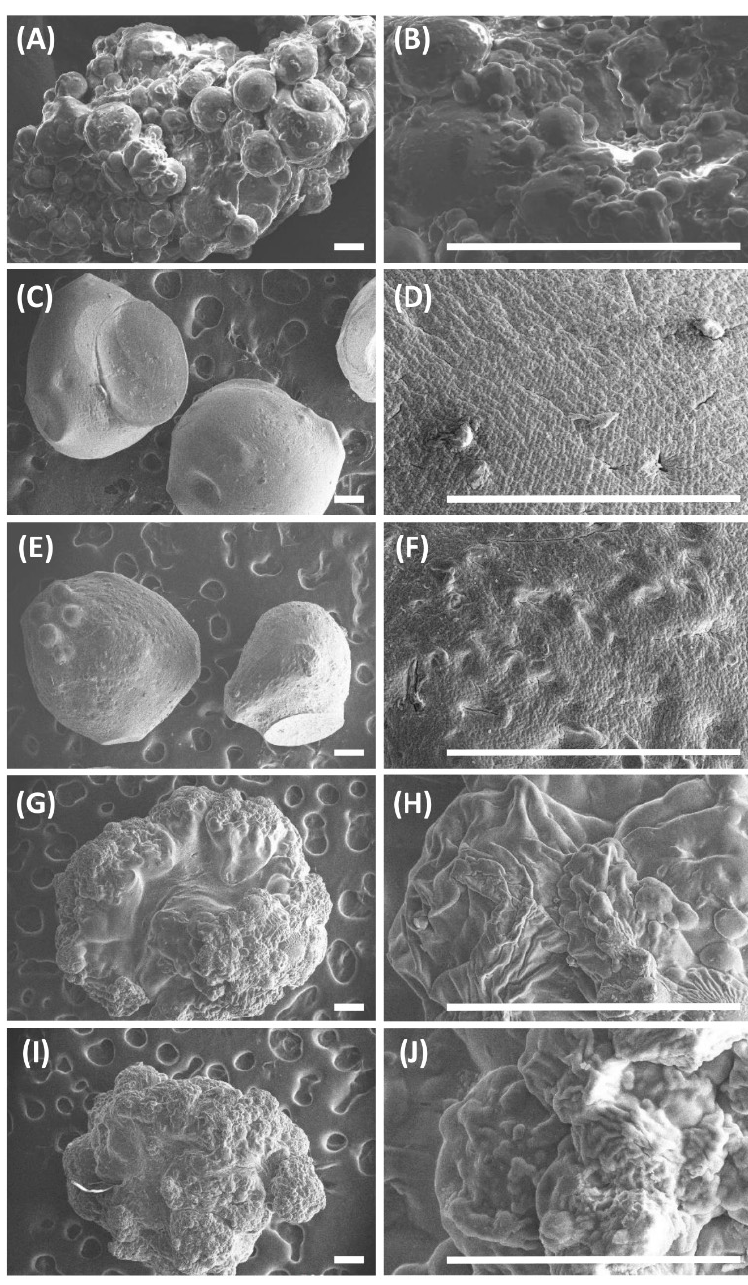
Figure 3. SEM images of ( A,B ) GL-DOX, ( C,D ) SA-5-FU, ( E,F ) SA-rGO-5-FU, ( G,H ) SA-5-FU-GL-DOX and ( I,J ) SA-5-FU-rGO-GL-DOX. Scale bar = 200 μ m.